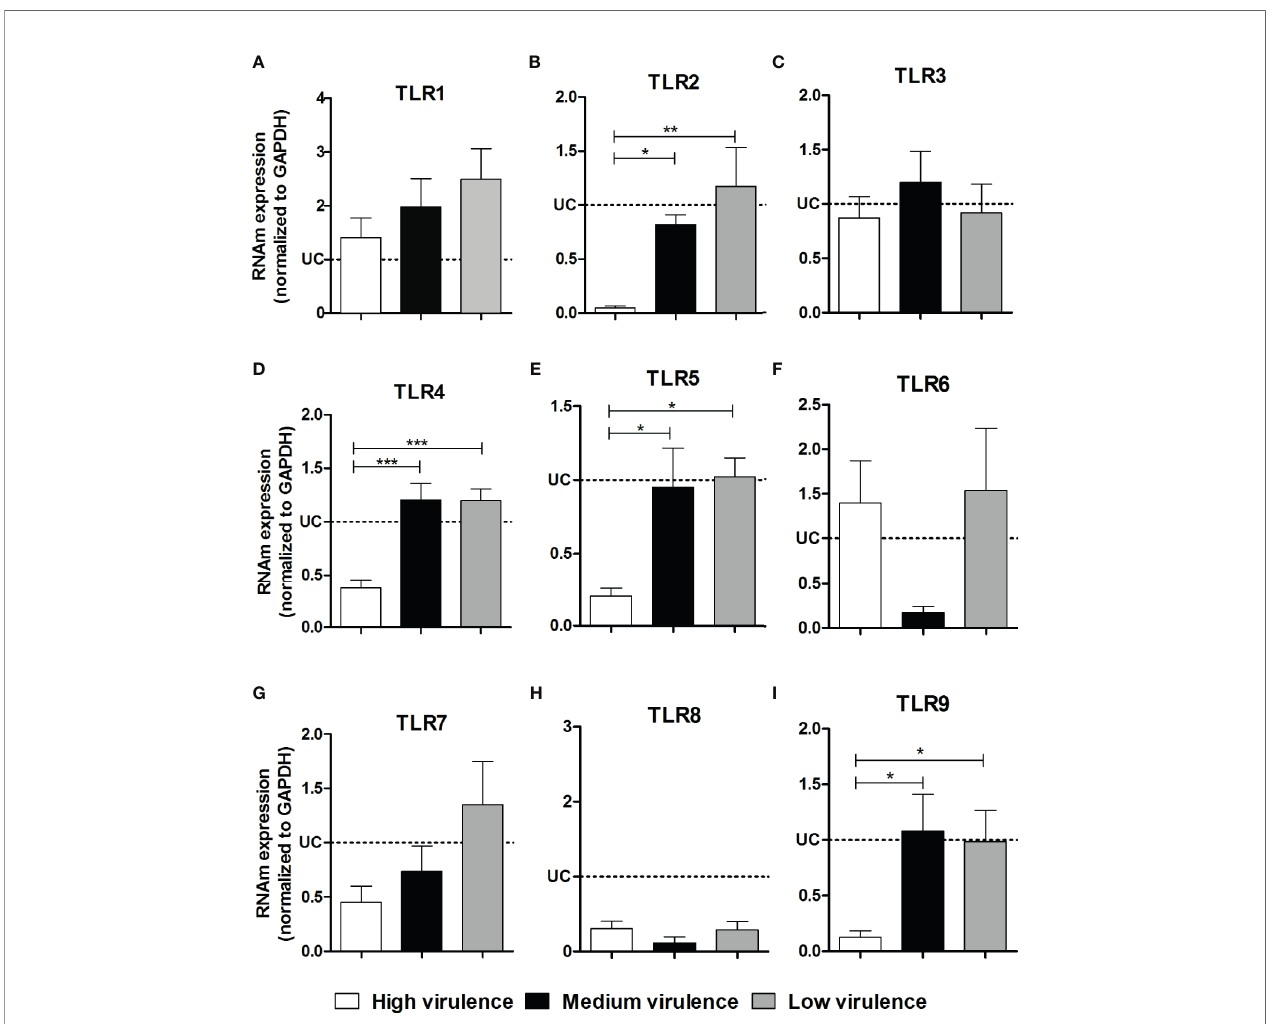
FIGURE 3 | Virulence of strains is correlated with TLR2, TLR4, TLR5, and TLR9 inhibition in heart from mice. The mRNA expression levels of TLR1 (A) , TLR2 (B) , TLR3 (C) , TLR4 (D) , TLR5 (E) , TLR6 (F) , TLR7 (G) , TLR8 (H) , and TLR9 (I) were determined by real-time PCR in heart of Swiss mice infected by the intraperitoneal route with 1 × 10 4 blood trypomastigote forms of T. cruzi strains that showed low (AM64 + 3253) (n = 10), medium (PL1.10.14 + CL) (n = 10) and high (Colombian + Y) (n = 10) virulence. The expression levels were normalized to the expression level of GAPDH. The results are expressed as the means ± standard errors. * p < 0.05; ** p < 0.01; *** p < 0.001. UC, uninfected control mice (n =